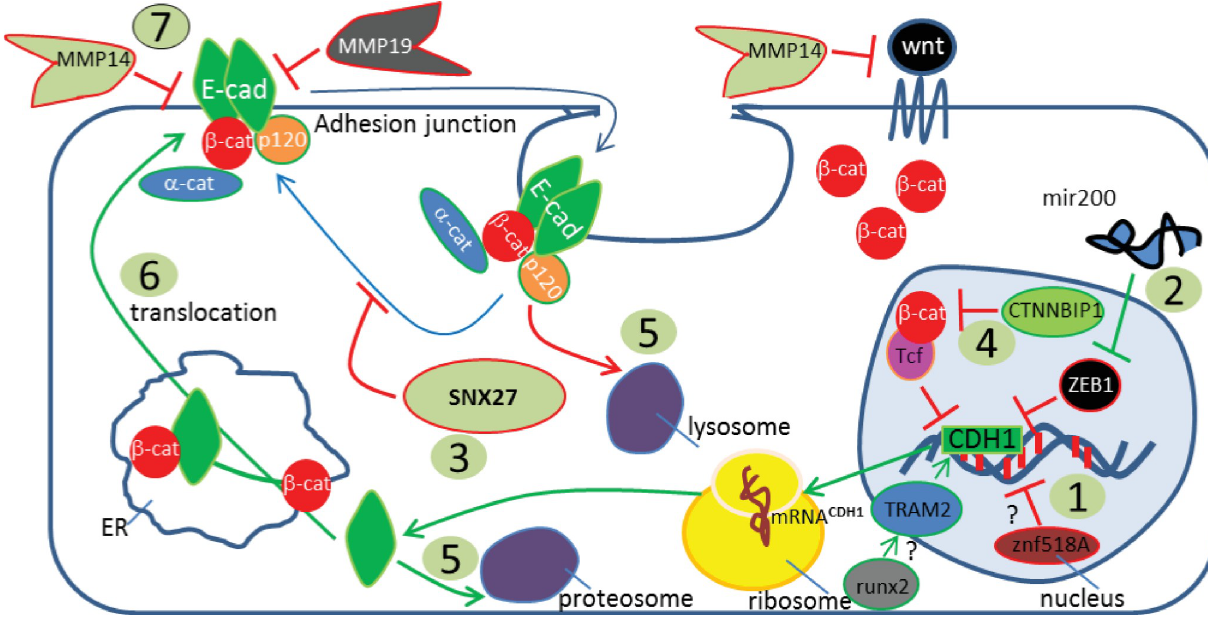
Fig 6. Model for the regulation of junctional E-cadherin. Schematic representation of biological processes identified in the siRNA screen for regulation of membrane-associated E-cadherin: 1. Gene transcription; 2. miR regulation (eg miR200 family); 3. Recycling of anti-adhesive or retention of pro- adhesive cargo by SNX27; 4. Inhibition of β -catenin/Tcf transcription; 5. Lysosomal or proteosomal degradation; 6. Translocation; 7. MMP14/ MMP19-mediated regulation. Negative (red) and positive (green) arrows and boundaries indicate regulation of membrane-associated E-cadherin are